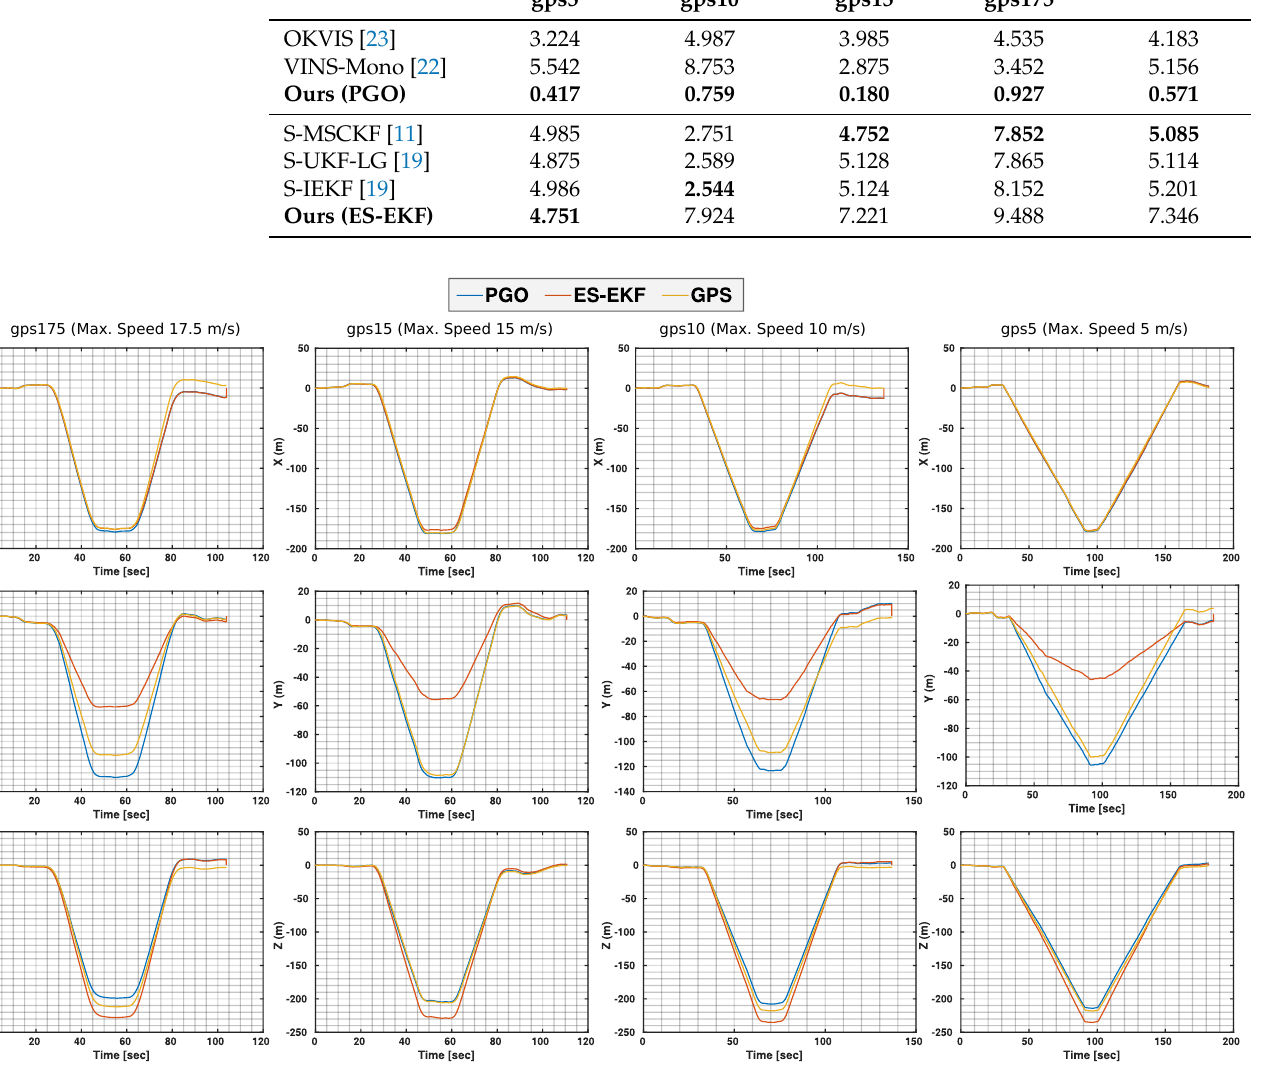
Figure 8. Fast Flight (X ( top ) − Y ( middle ) − Z ( bottom )) trajectory estimation compared to the GPS